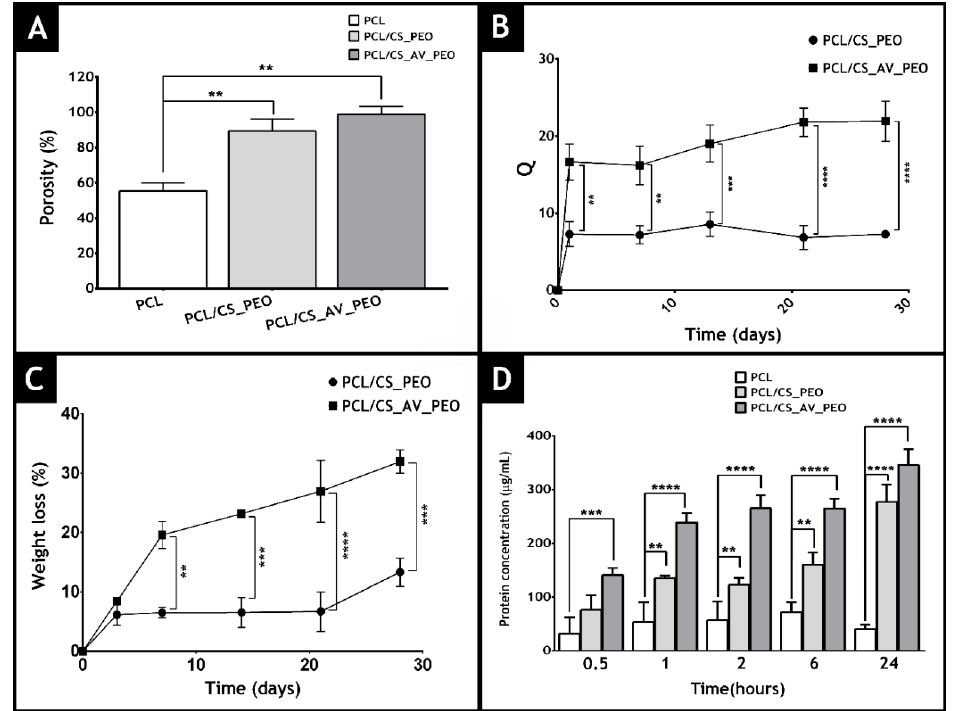
Figure 5. Characterization of the total porosity ( A ), swelling profile ( B ), weight loss ( C ), and protein adsorption ( D ) on the membrane’s surface at different time points.